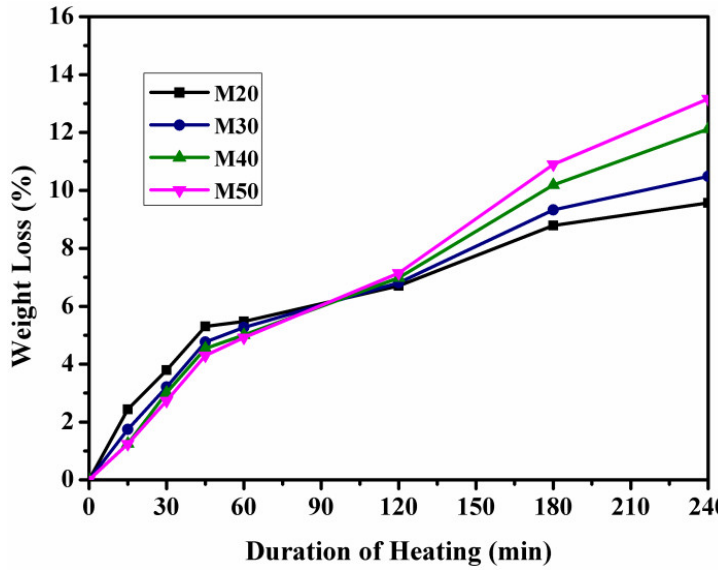
Figure 9. WL of concrete specimens subjected to heating.